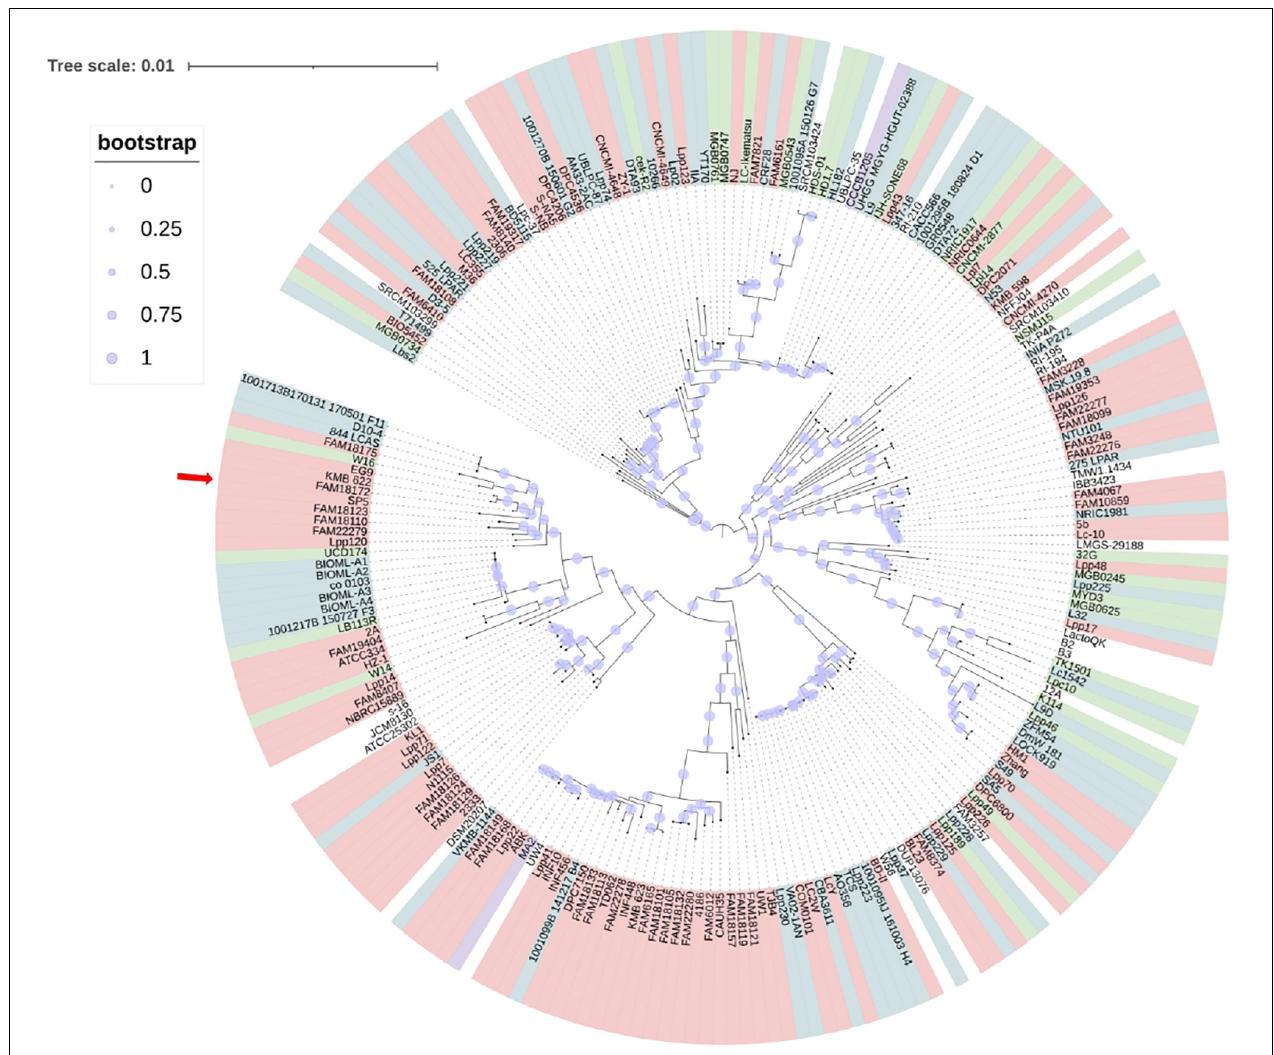
FIGURE 2 | Approximately-maximum-likelihood phylogenetic tree of all available (239 as of January 2022) Lc. paracasei isolated from various sources (light pink – dairy products, blue – host-associated strains, green – vegeTables–associated strains, lilac – strains isolated from non-dairy beverages) based on orthologous genes calculated by Roary (version 3.13.0) and built with 1,000 bootstrap replications. The red arrow indicates the position of Lc. paracasei SP5 in the phylogenetic